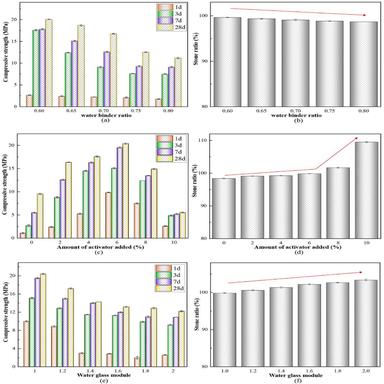
Influence of raw material ratio on compressive strength and stone ratio of grouting materials (a-b:The activator ratio is 2%, the water glass modulus is 1.0, and the water binder ratio is 0.6–0.8. c-d:The ratio of activator is 0–10%, the modulus of sodium silicate is 1.0, and the water binder ratio is 0.7. e–f: the ratio of activator is 6%, the modulus of sodium silicate is 1.0–2.0, and the water binder ratio is 0.7).